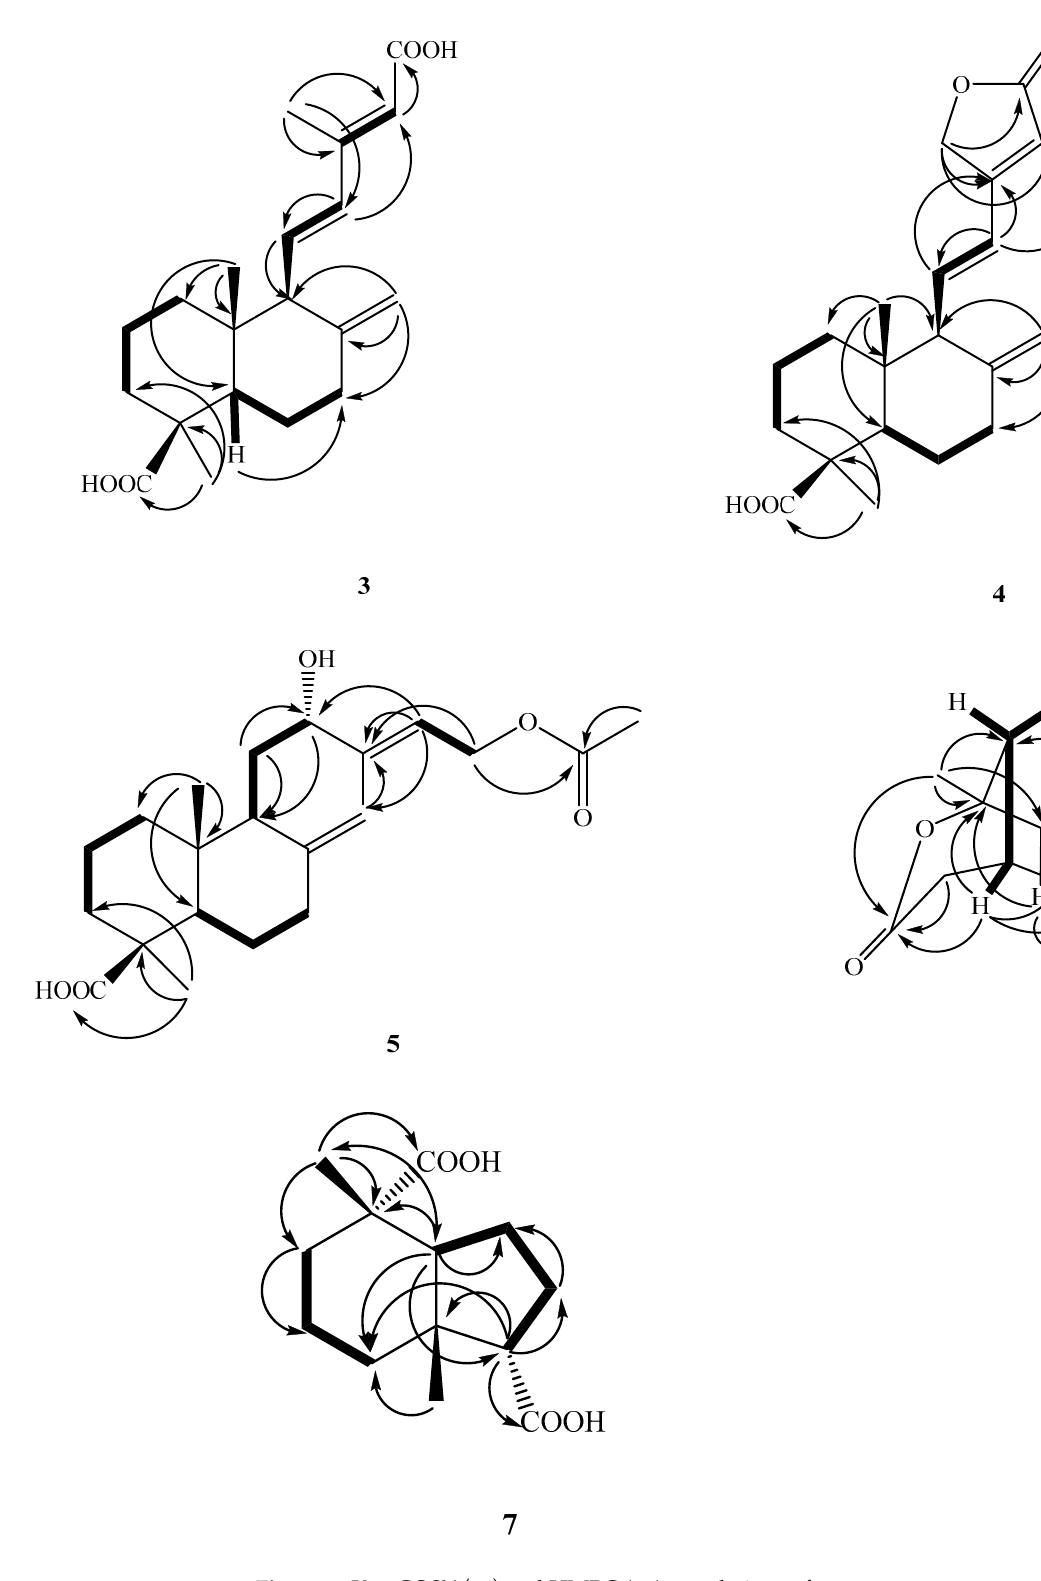
Figure 2. Key COSY ( ▬ ) and HMBC ( → ) correlations of 1 ‒ 7 .